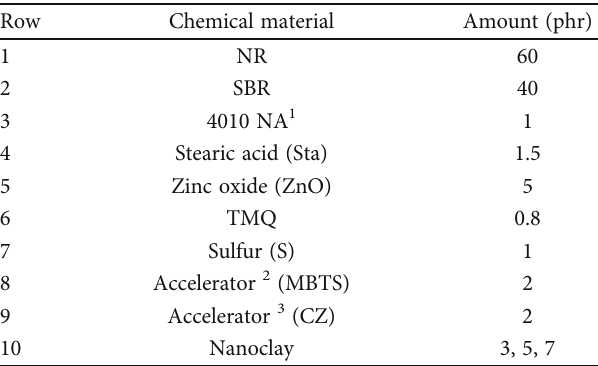
Table 2: Chemical composition of rubber samples.